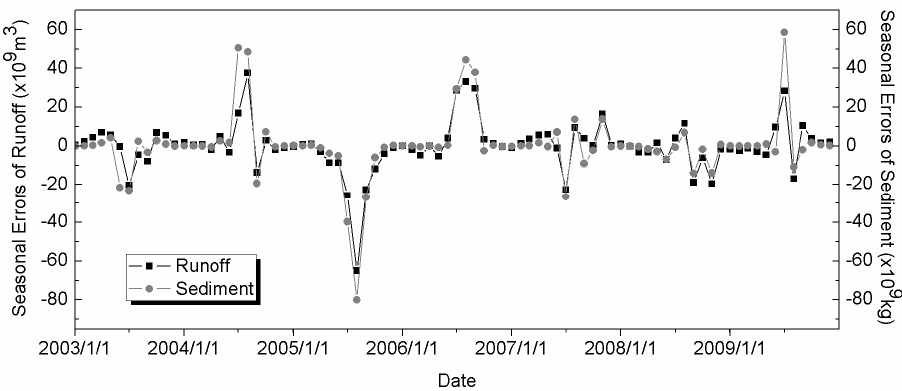
Figure 8. Sequences after removing seasonal effect. Table 2. ADF test results of residuals removing the seasonal effect a .